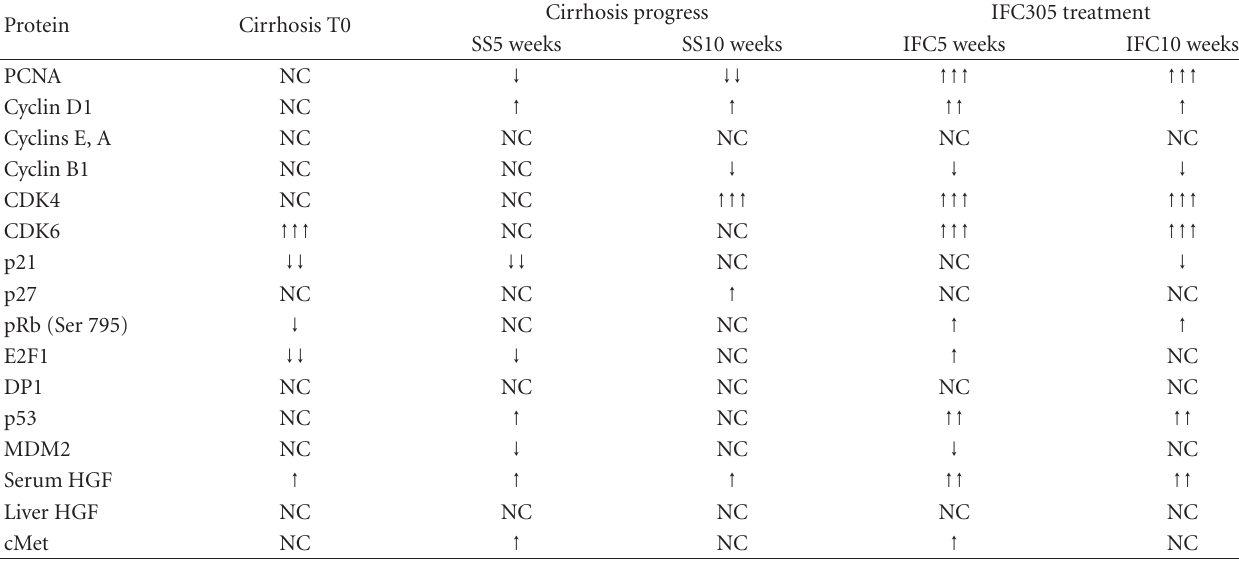
Table 2: Summary of the e ff ects of IFC305 treatment on protein expression in CCl 4 -induced cirrhosis.